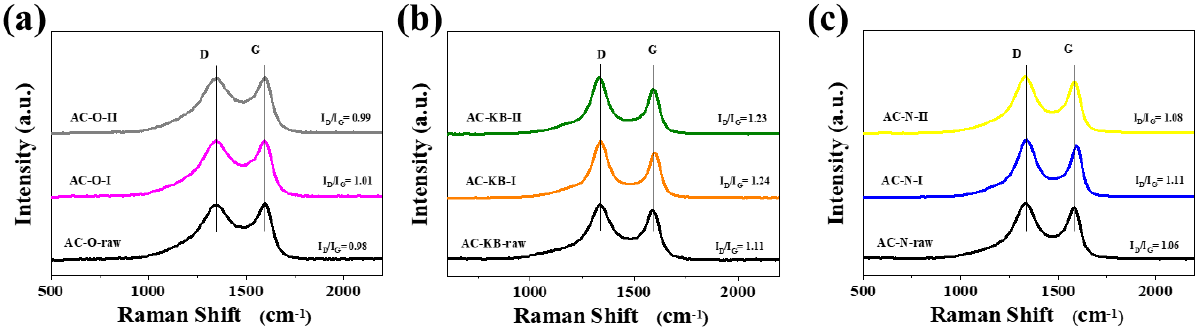
Figure 4. Pore size distribution obtained from the adsorption branches of N 2 used the nonlocalized density functional theory (NDLFT) method of all investigated series of the obtained samples: ( a ) AC–O; ( b ) AC–KB; and ( c ) AC–N. Raman spectroscopy was used to better characterize the obtained materials. Raman